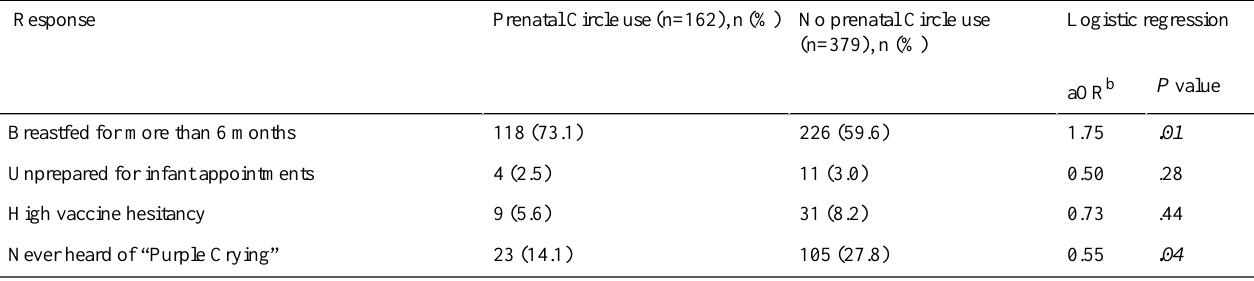
Table 4. Responses from participants on caring for infants (n=541 a ). Italicized P values are significant.